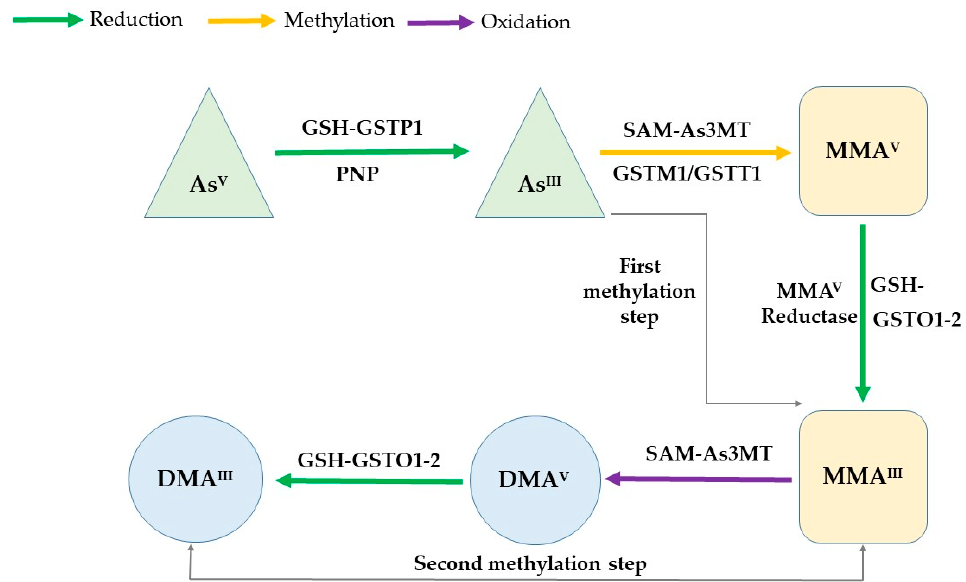
Figure 1. The classical pathway for explain the mechanism of arsenic metabolism. The As V is reducing to As III through a conjugation reaction among Glutathione (GSH as the electron donor) and Glutathione-S-transferase enzymes (GSTP1), as well as purine nucleoside phosphorylase (PNP) enzymes. As III species are methylated to monomethylarsonic acid (MMA V ) and dimethylarsinic acid (DMA V ). The enzyme participant is Arsenic (+3)-methyl-transferase (As3MT), using S-adenosyl-methionine ( SAM -methyl donor). GSH and GSTO1–2 involve in a conjugated reaction to form the intermediate products monomethylarsonous acid (MMA III ) and dimethylarsinous acid (DMA III ). The MMA V reductase enzyme is responsible for the reduction of MMA V to MMA III .